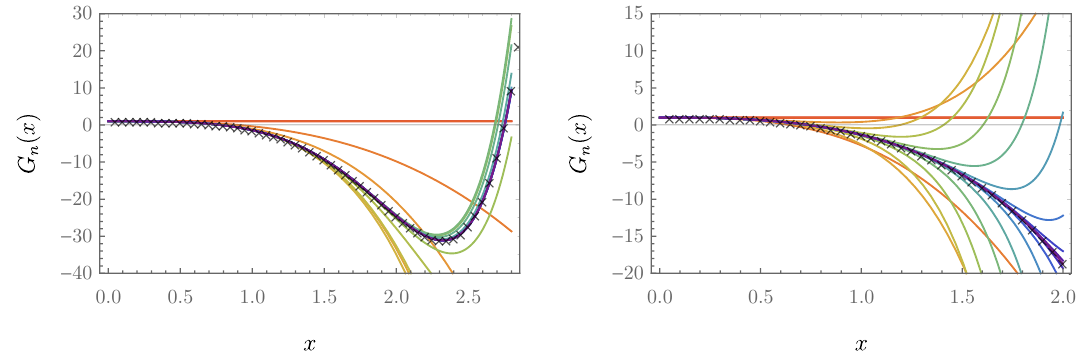
Figure 6 . Partial sums G n ( x ) = P n G ( ‘ ) x ‘ (cid:0) 1 for n = 1 ; : : : ; 22 (rainbow, red through violet) ‘ =1 and numerical results for G ( x ) (black crosses). The plot illustrates convergence in that increasing the order n extends the range of x for which the partial sum matches the numerical result. The (cid:12)gure shows the singlet (left) as well as the 27 exchange